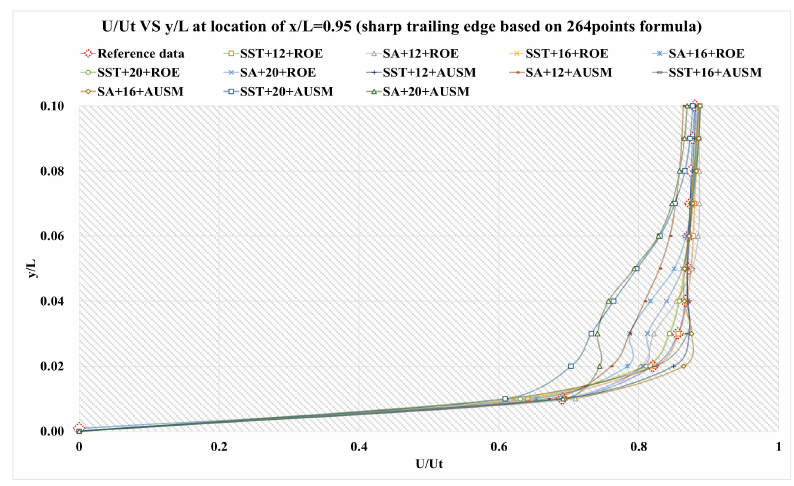
Figure 15. Distributions of U/U t of the sharp trailing edge based on 264 points formula at location of x/L = 0.95. Table 15. The mean error ratios of P/P t , T/T t , and U/U t of the sharp trailing edge based on 264points.